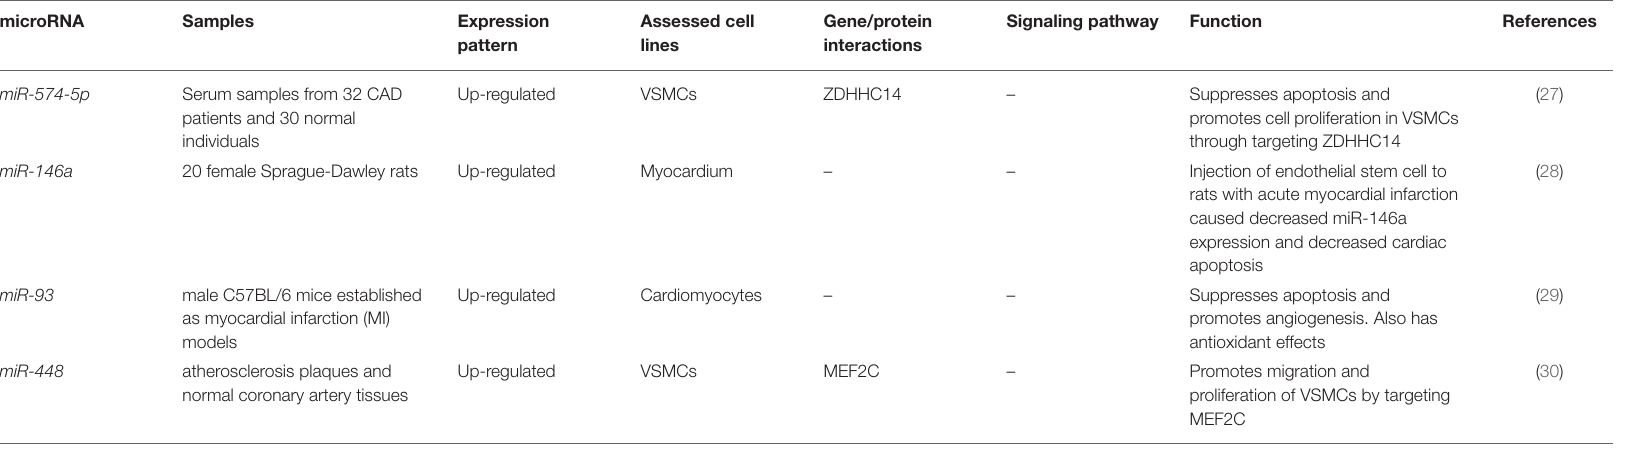
TABLE 2 | CAD-related miRNAs whose function has been assessed in myocardial cells or vascular smooth muscle